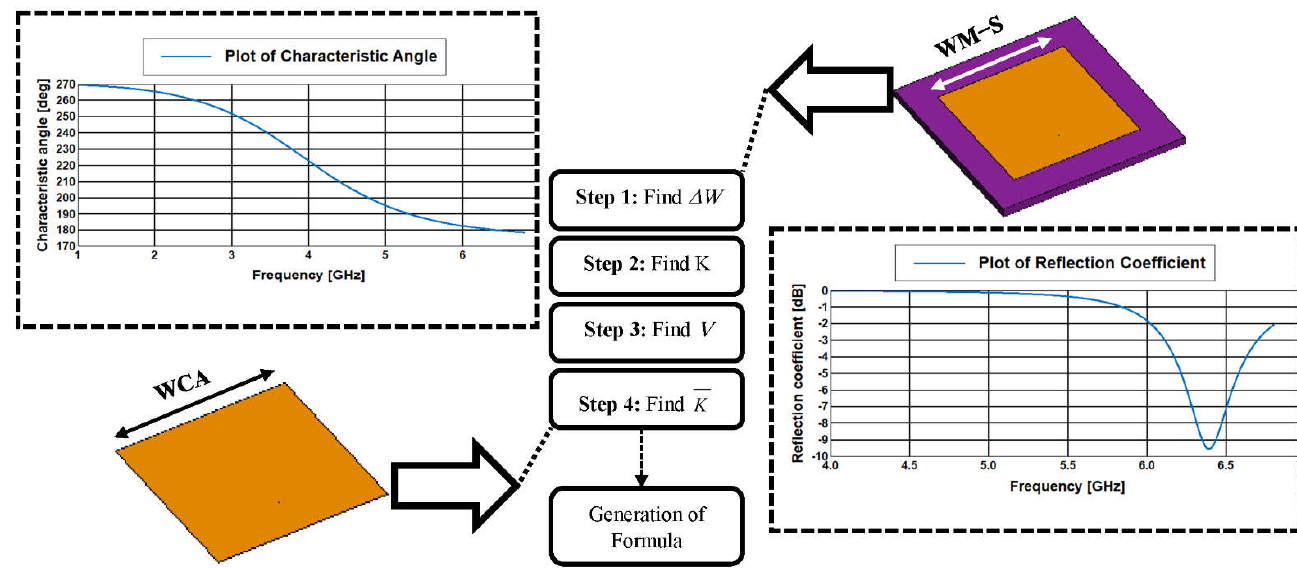
Figure 4. Deviation of results for different substrates.